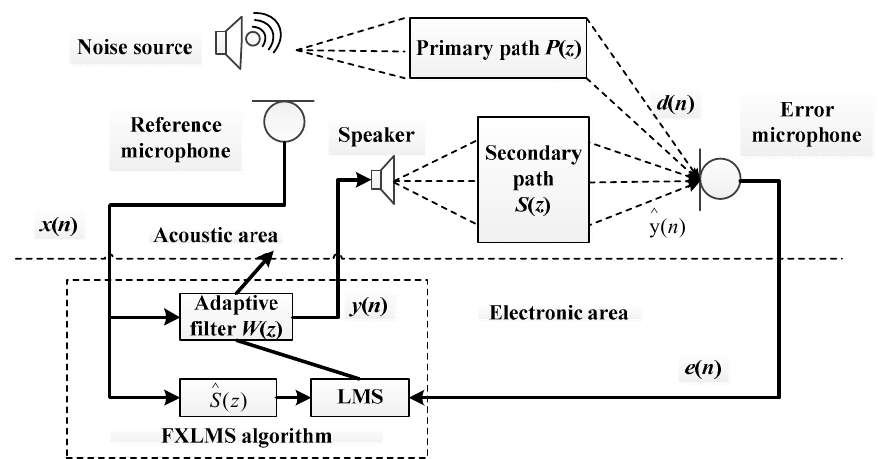
Figure 2. Schematic diagram of ANC system structure.